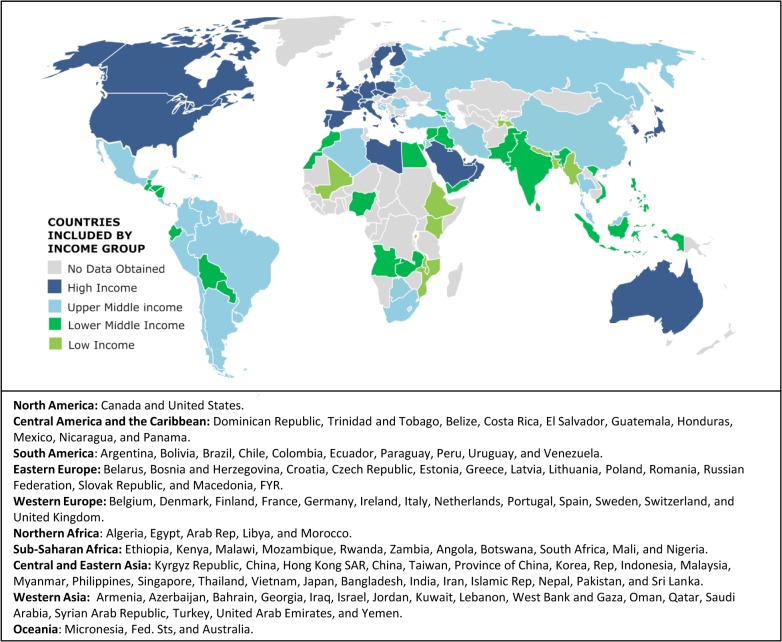
Countries included in the study by World Bank income group classification in 2010 and geographical region.Country names listed are as they appear in World Bank. HIC, high-income countries; UMIC, upper-middle-income countries; LMIC, lower-middle-income countries; LIC, low-income countries. Some countries (such as Chile and Russian Federation) have a higher income group and some countries (such as Libya) have lower income group classification as of 2015, but are illustrated and were kept in the economic bracket assigned through 2010 data in all analyses.